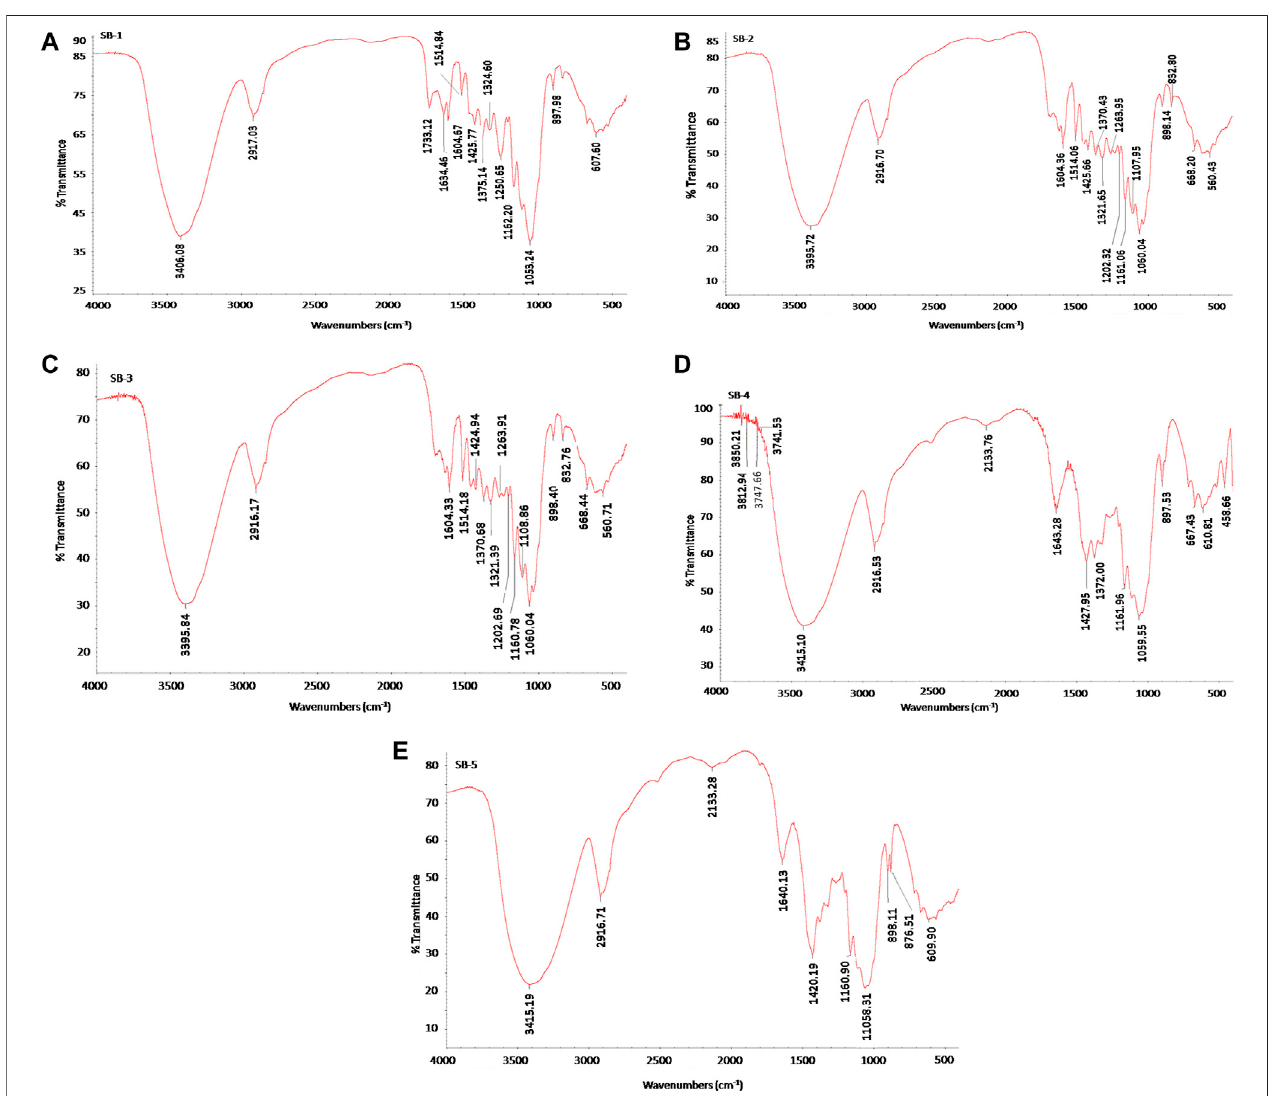
FIGURE1| Fouriertransform infrared(FTIR)spectraofuntreated,acid-,andalkali-pretreatedsugarcanebagasse(SB). (A) Untreatedsugarcanebagasse, (B) 5% sulfuric acid-pretreated bagasse at 121 ° C for 60 min, (C) 10% sulfuric acid-pretreated bagasse at 121 ° C for 60 min, (D) 5% sodium hydroxide-pretreated bagasse at 121 ° C for 60 min, and (E) 10% sodium hydroxide-pretreated bagasse at 121 ° C for 60 min.